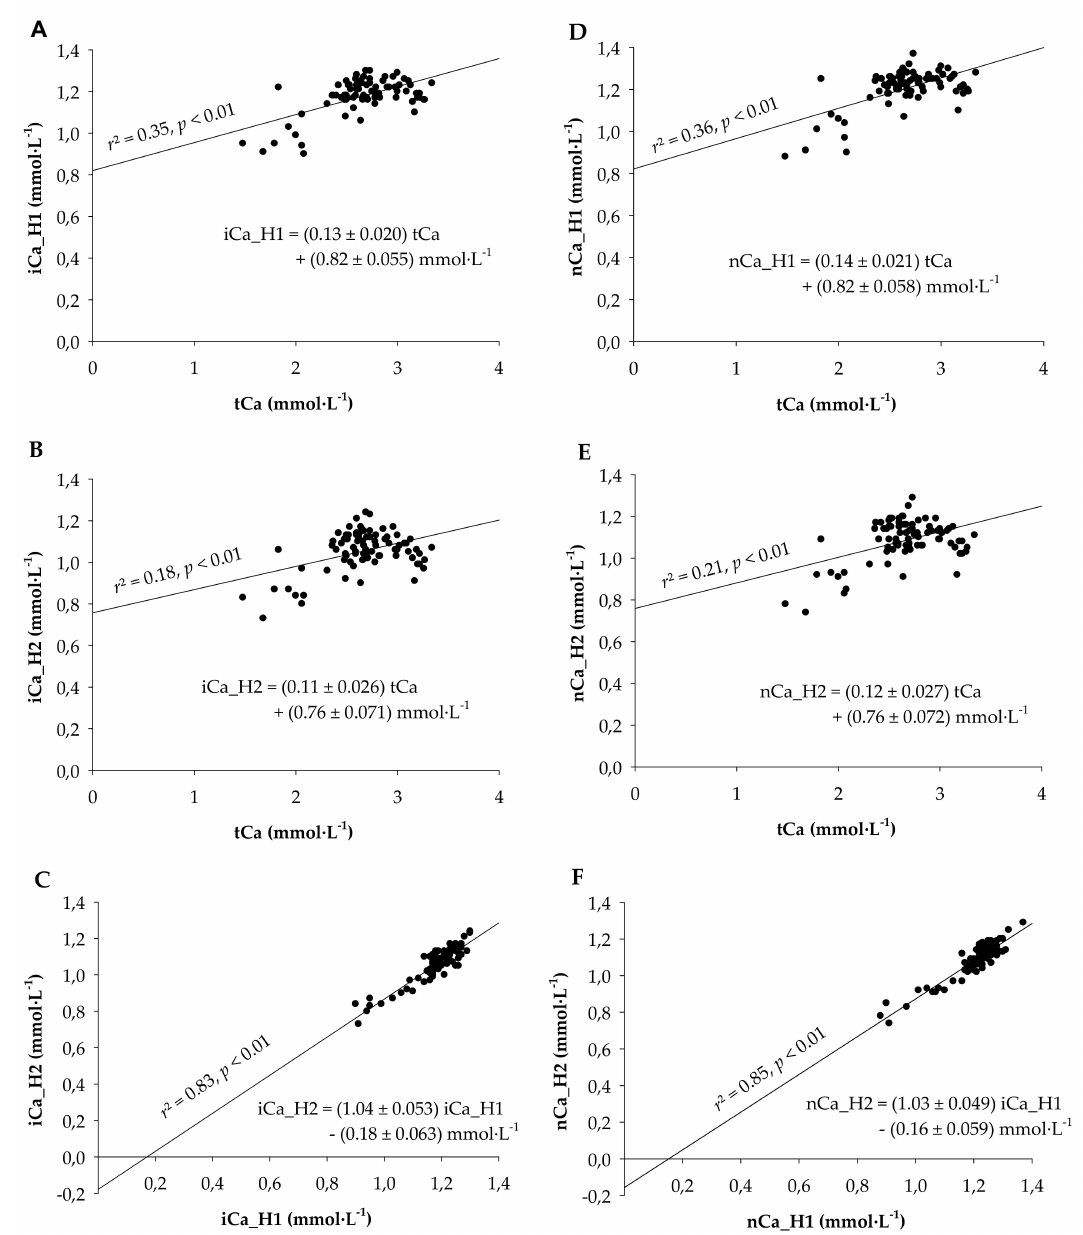
Figure 1. Correlations and regression analyses ( A ) between plasma ionized calcium measured from a heparinized vacutainer (iCa_H1) and serum total calcium (tCa), ( B ) between plasma ionized calcium measured from a heparinized capillary filled from a heparinized vacutainer (iCa_H2; double heparinization) and serum total calcium (tCa), and ( C ) between iCa_H2 and iCa_H1. ( D – F ) Regression analyses corresponding to graphs A-C where ionized calcium values were replaced by the ionized calcium values normalized to a pH of 7.4. All slopes and intercepts were different from zero ( p < 0.01). Blood was taken from 14 multiparous Holstein-Frisian cows between − 2 and 14 days relative to